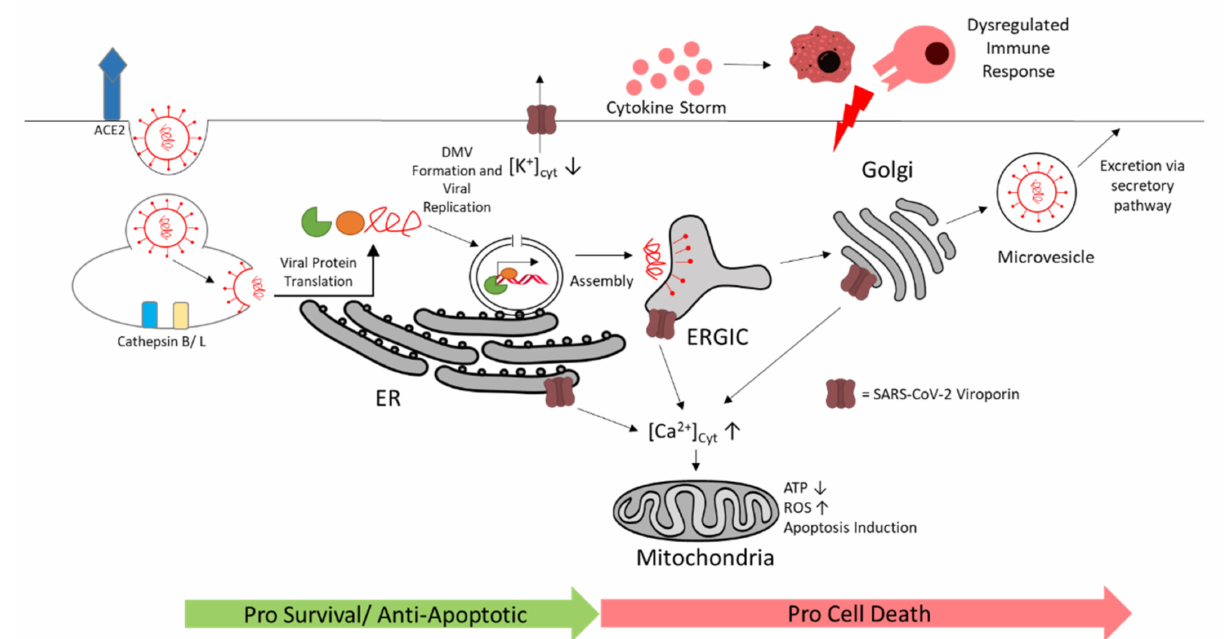
Figure 10. SARS-CoV-2 virus–host interactions. ACE2, angiotensin-converting enzyme 2; ER, endoplasmic reticulum; ERGIC, ER–Golgi intermediate compartment; ATP, adenosine triphosphate; ROS, reactive oxygen